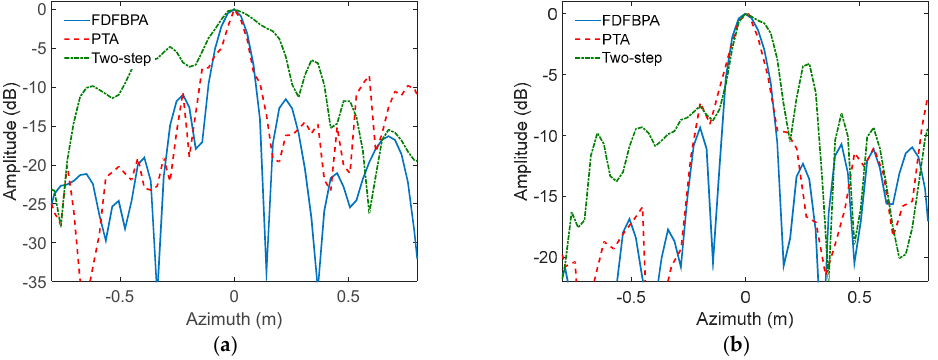
Figure 8. Comparison of three algorithms in Scene 1 and Scene 2: ( a ) Comparison of Scene 1 (left to right: FDFBPA, PTA and Two-step MOCO); ( b ) Comparison of Scene 2 (left to right: FDFBPA, PTA and Two-step MOCO).